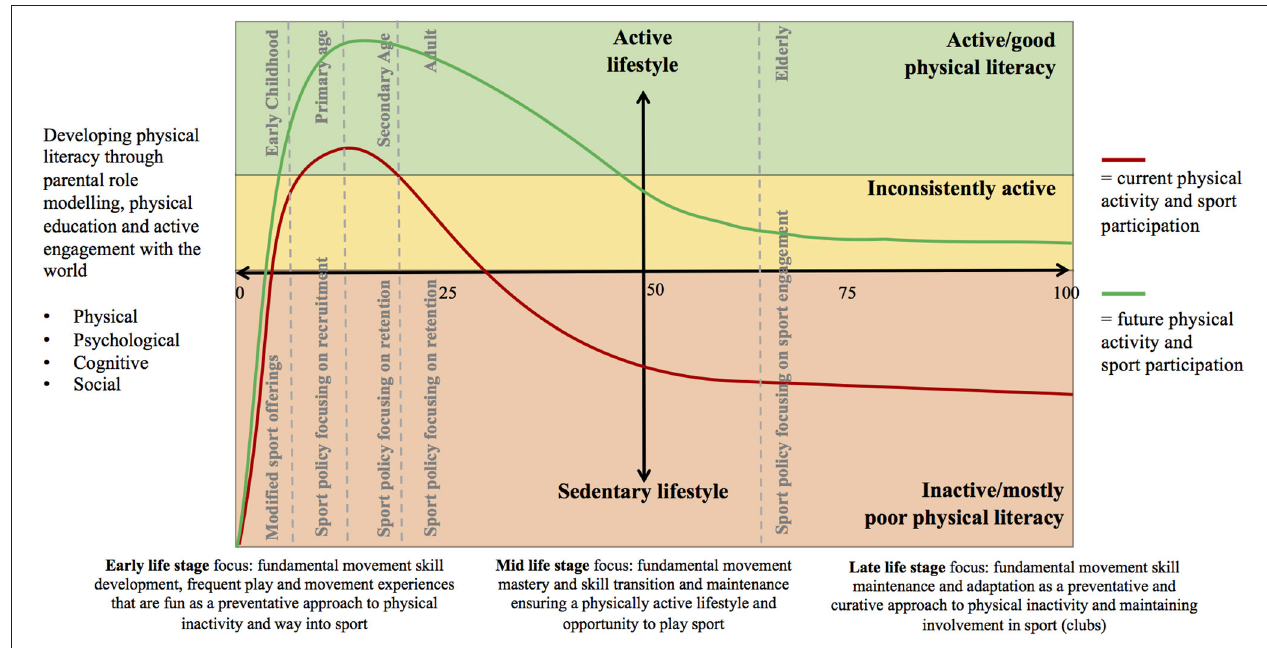
FIGURE 1 | The Physical Activity and Sport Participation (PASP)